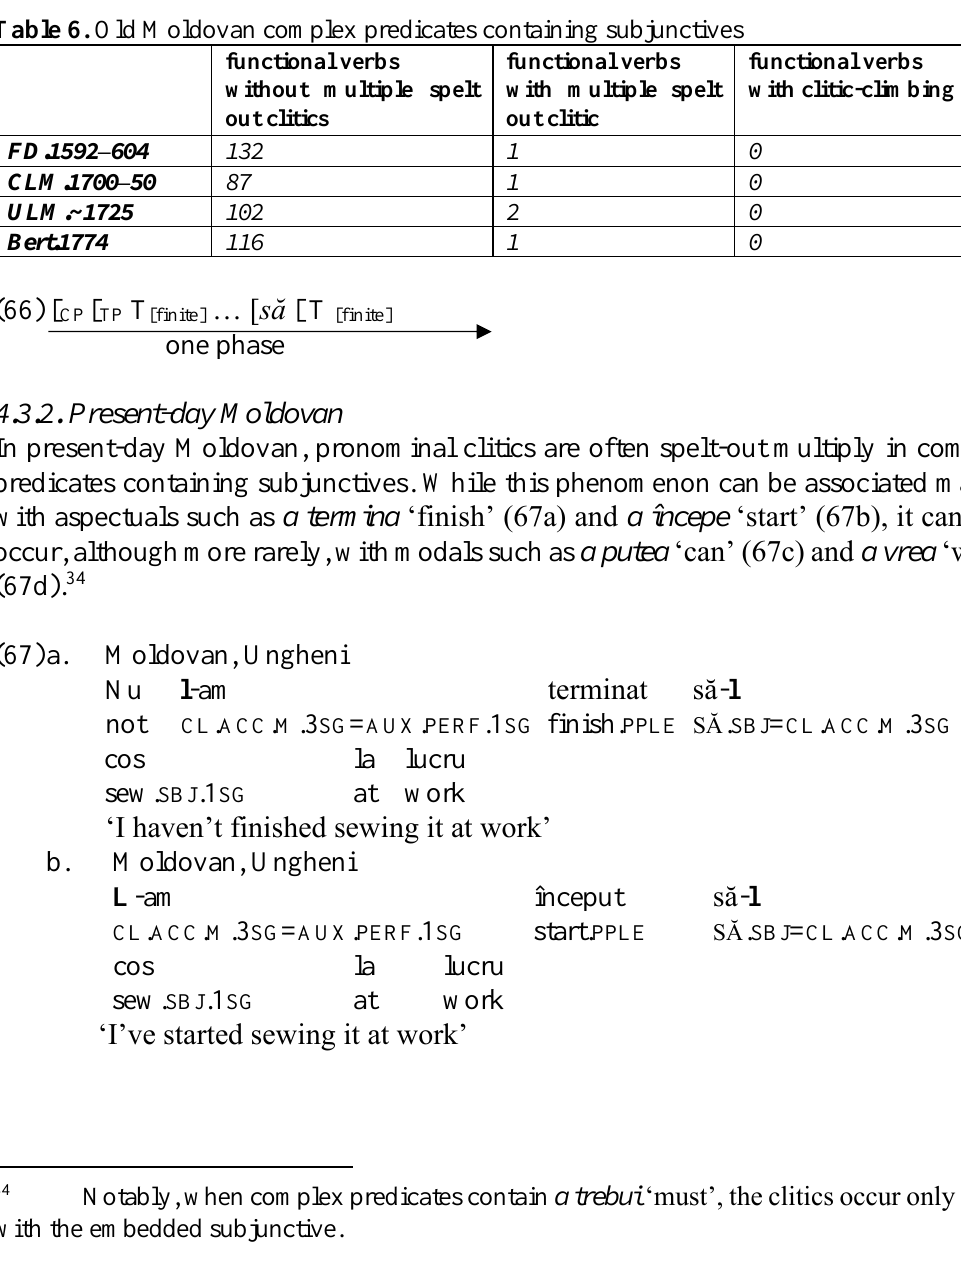
Table 6. Old Moldovan complex predicates containing subjunctives functional verbs without multiple spelt out clitics ULM.~1725